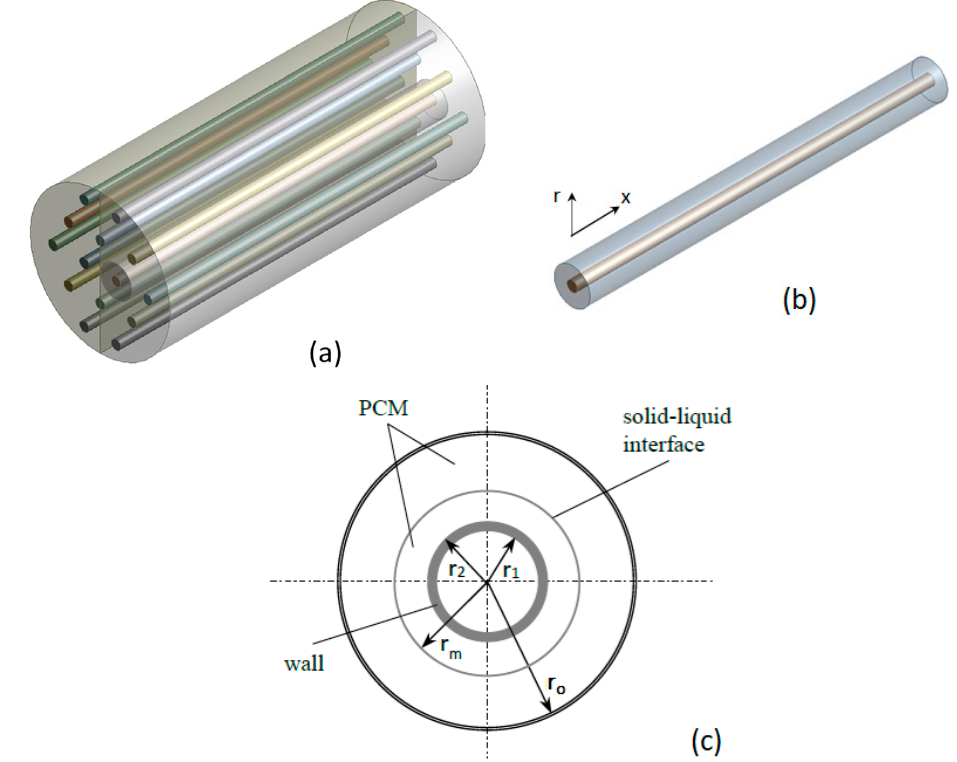
Figure 1. Schematic diagram of: ( a ) a shell-and-tube TES system; ( b ) one modelled storage unit and ( c ) top view of one cross-section of the modelled unit.